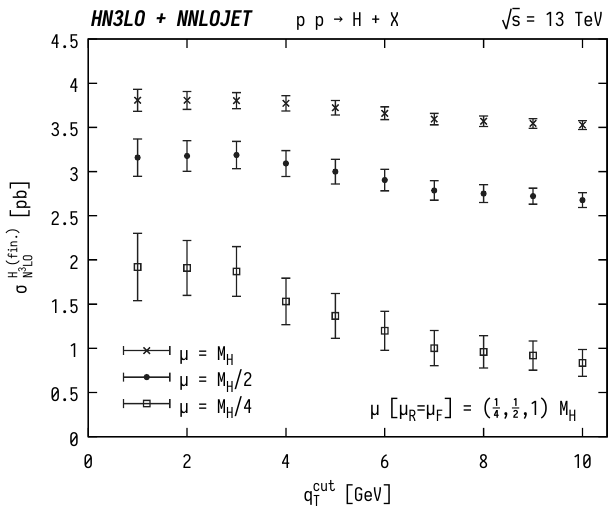
Figure 1 . The q T integrated (cid:12)nite contribution to the cross section of eq. (3.3) at N 3 LO-only (i.e. N 3 LO (cid:0) NNLO) between q cut